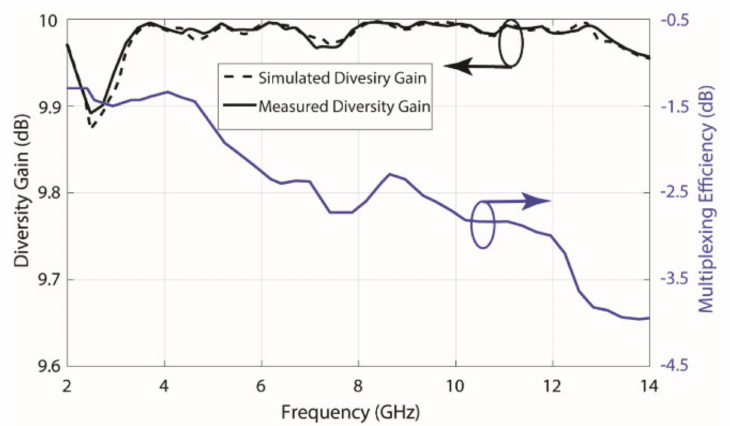
Figure 12. Diversity gain and multiplexing efficiency over the entire